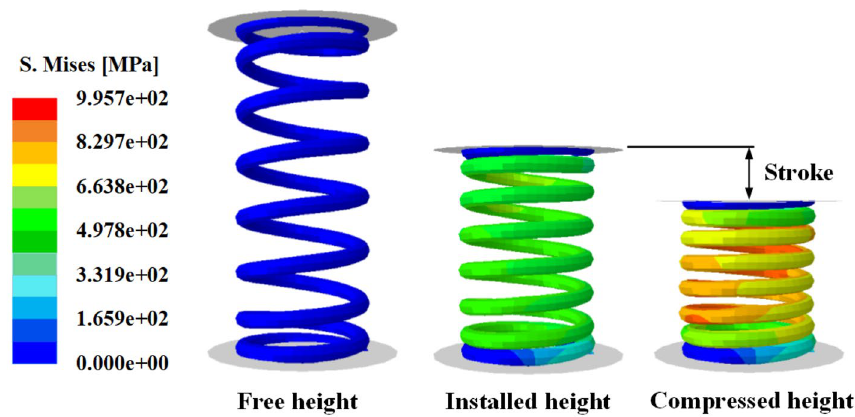
Figure 21. Operation conditions of automotive engine valve